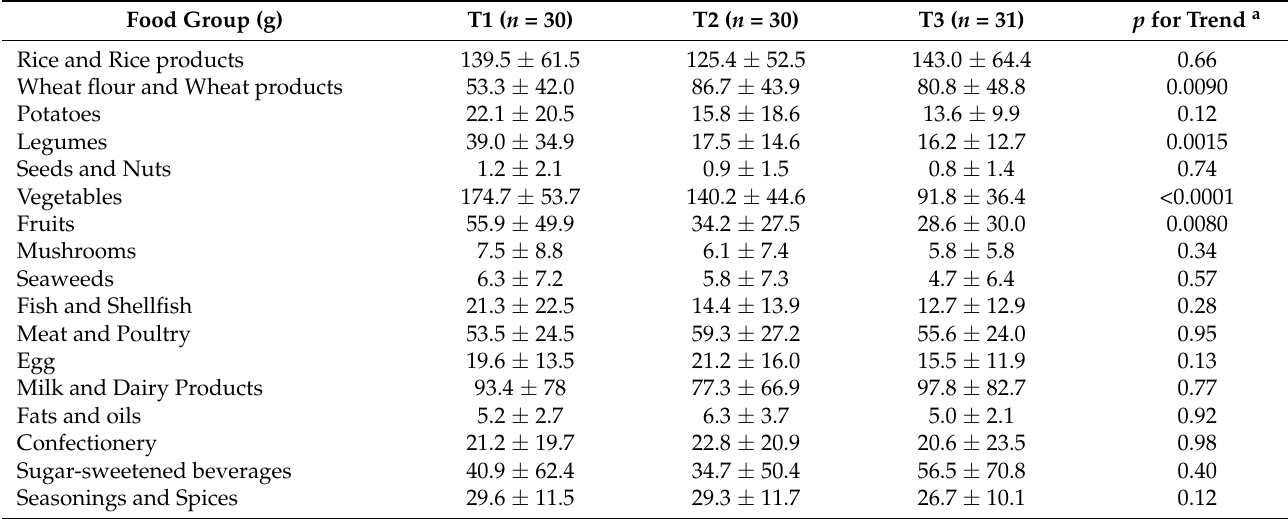
Table 5. Sensitivity analysis for food group intake across the tertile (T) categories of energy-adjusted dietary inflammatory index (E-DII) score after excluding the participants with misreported energy